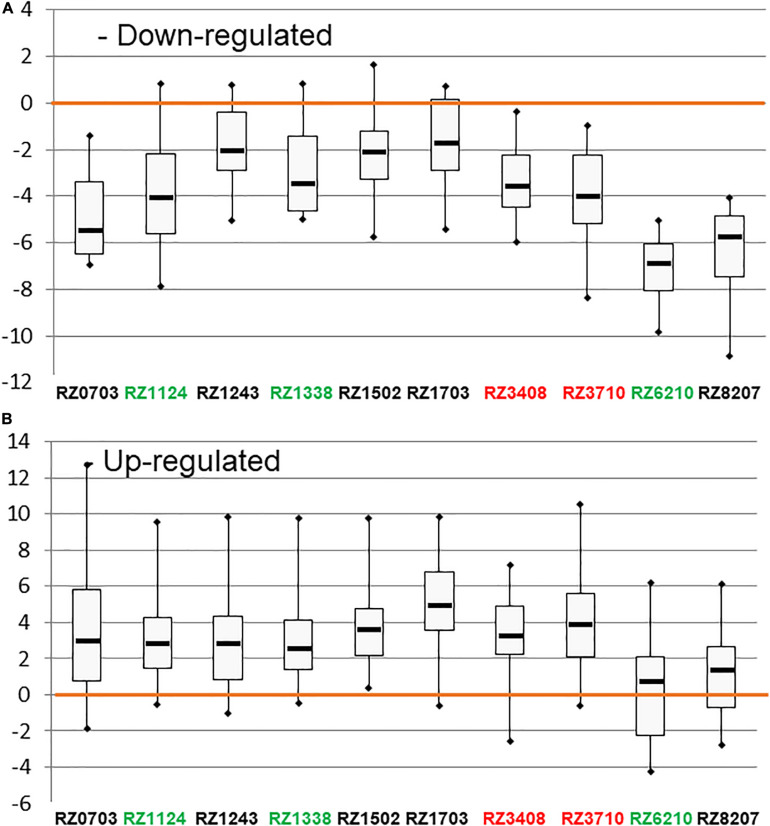
Box plots representing the distribution of the expression of down-regulated (A) and up-regulated (B) DEGs (as in Supplementary Table 6) in [log2(gene expression ratio)] in the 10 chosen Aragonez clones. The color code of the varieties’ names, according to the overall SLT analysis, is the following: red: sensitive, green: tolerant, black: variable.